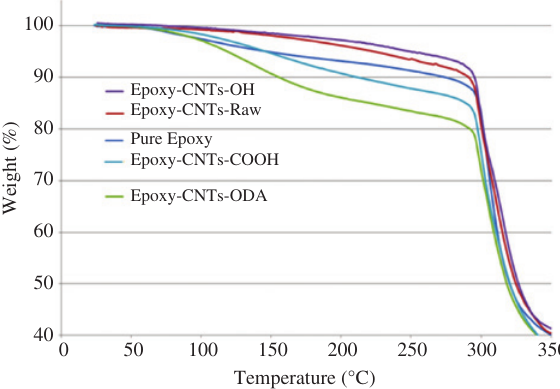
Figure 8: TGA curve of pure epoxy and various CNT composites.